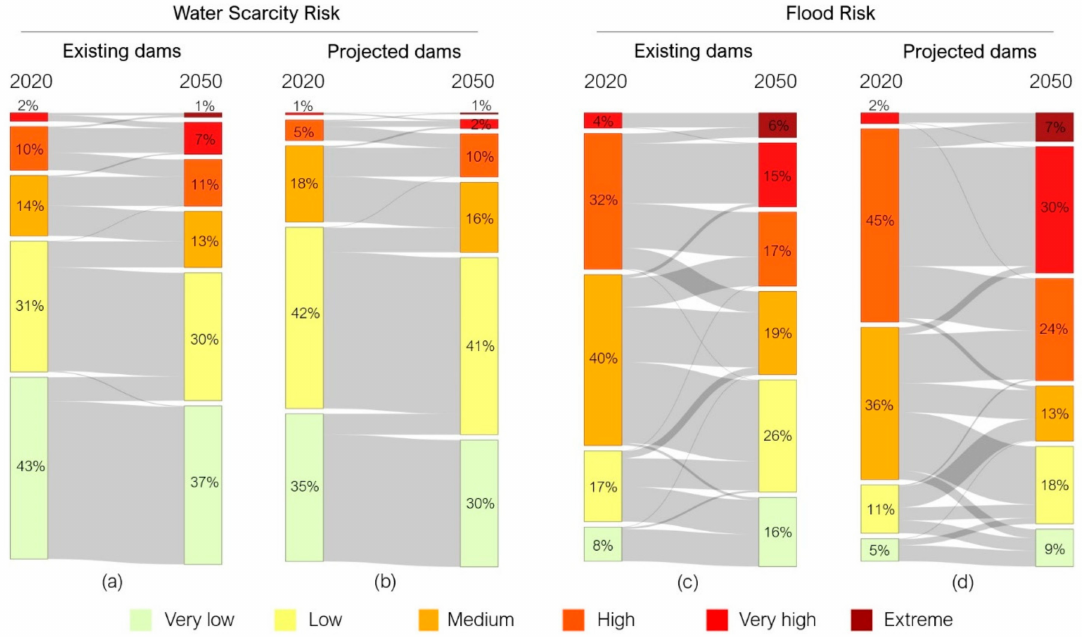
Figure 3. The shift in risk classes between 2020 and 2050 (pessimistic scenario) for existing and projected hydropower projects, in water scarcity ( a , b ) and flood risk ( c , d